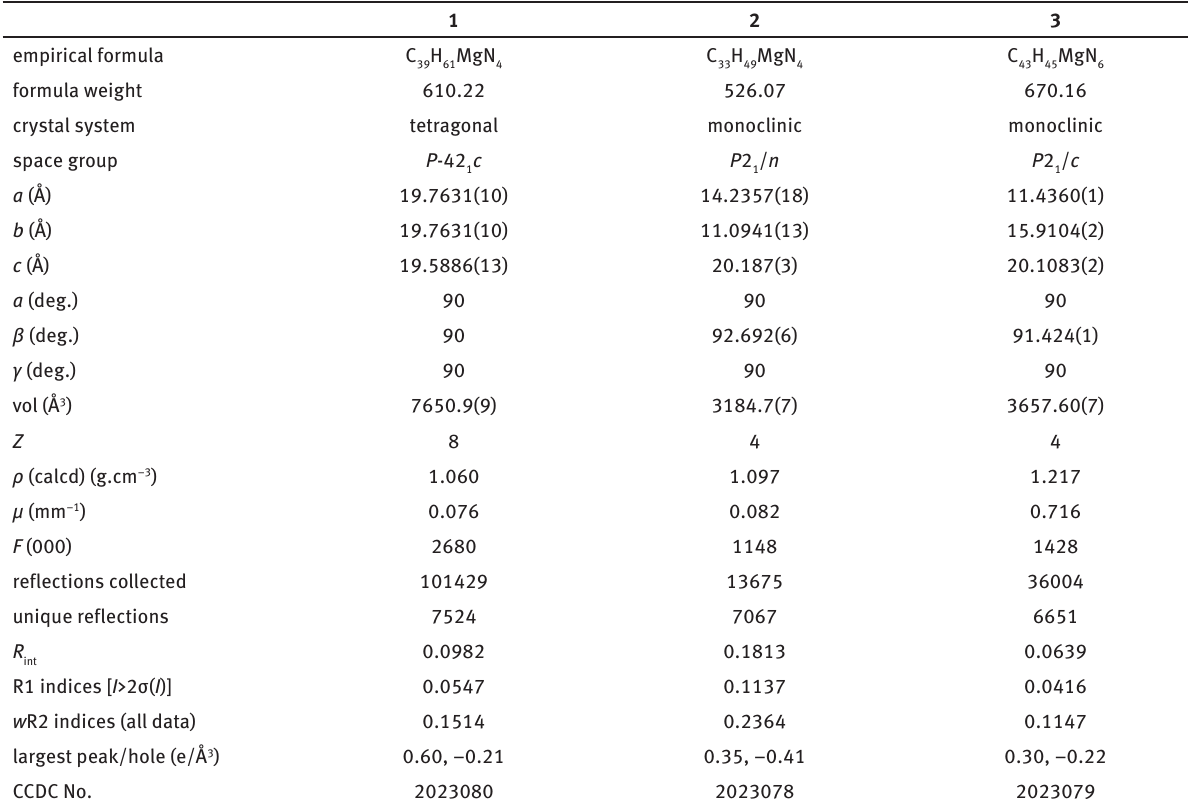
Table 1: Summary of crystallographic data for 1 - 3